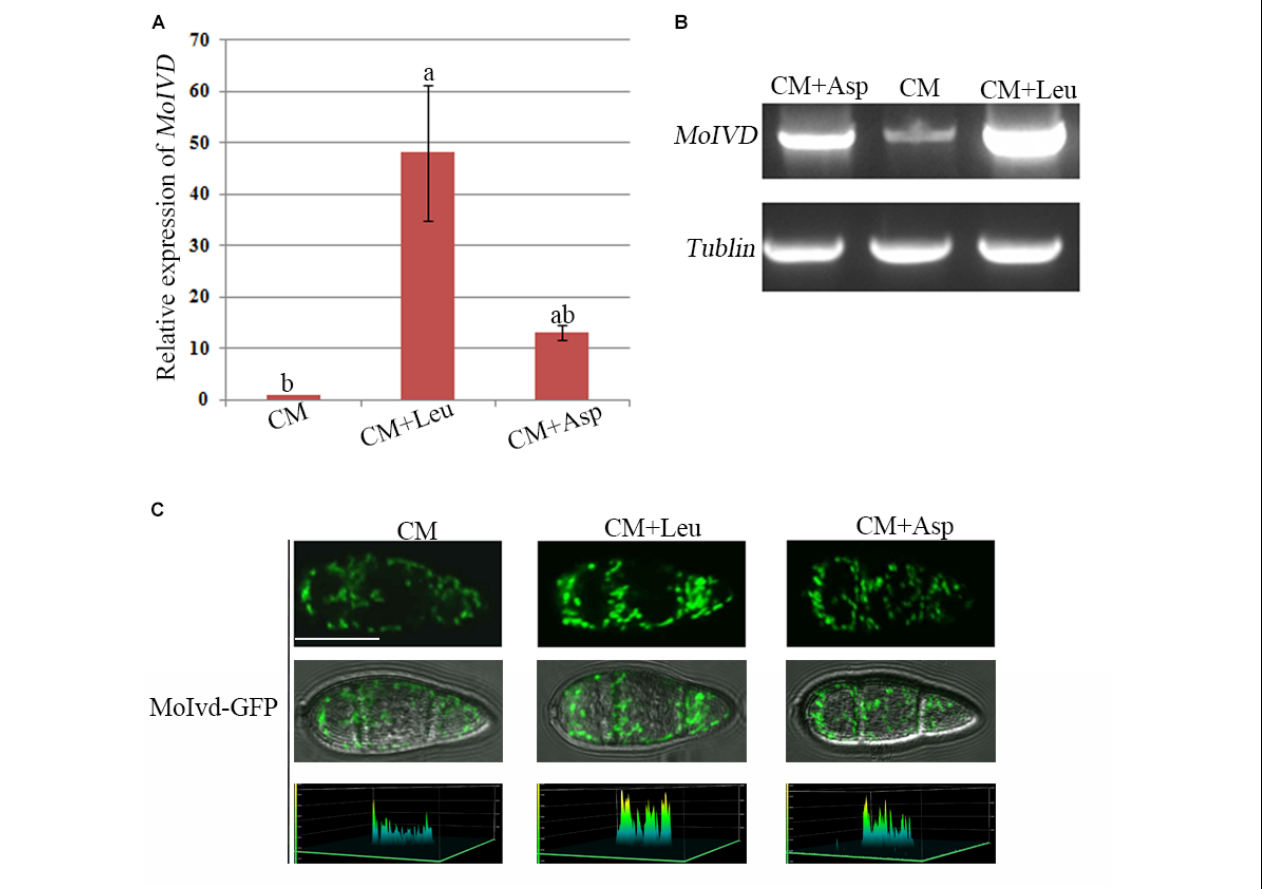
FIGURE 2 | The MoIVD expression was highly induced by exogenous leucine. (A) qRT-PCR test of the relative MoIVD expression in fungus treated with 0.1 M leucine (Leu) and 0.1 M aspartic acid (Asp). (B) Semi qRT-PCR and electrophoresis test of MoIVD expression in fungus treated with 0.1 M Leu and 0.1 M Asp. (C) The fluorescence intensity of MoIvd-GFP in conidia treated with 0.1 M Leu and 0.1 M Asp. The peaks in the 3D chart show the signal intensity. The 3D chart was generated by laser scanning confocal microscopy. Bar = 10 µ